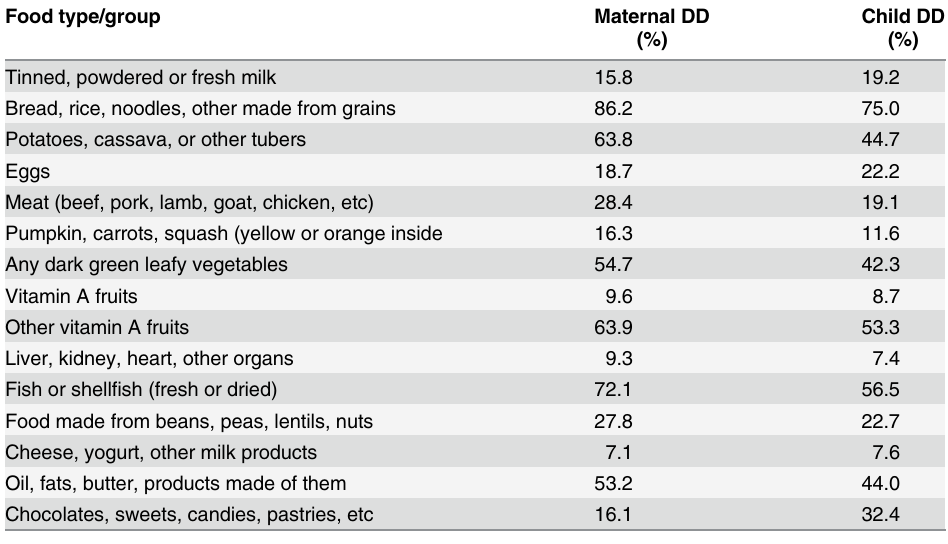
Table 3. Food groups/types used in creating the maternal and child dietary diversity (DD). Food type/group Maternal DD Tinned, powdered or fresh milk